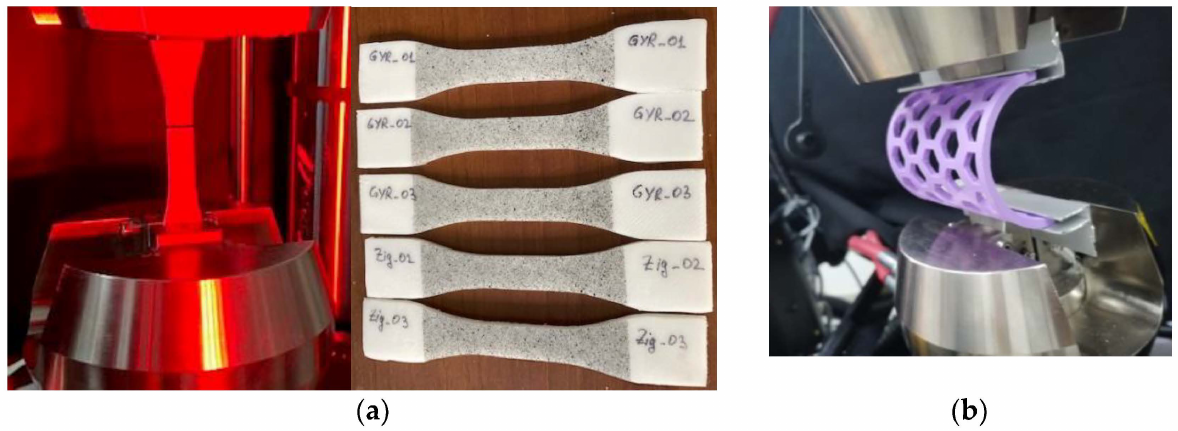
Figure 4. Mechanical test set-ups: DIC tensile ( a ); bending of the semi-cylindrical samples ( b ). Stress ( σ ) was computed as the maximum normal stress under the calculated bending moment (Equation (1)), and strain ( ε ) as the maximum strain in the section with the maximum deflection (Equation (2)), according to the ASTM D790 standard [31], based